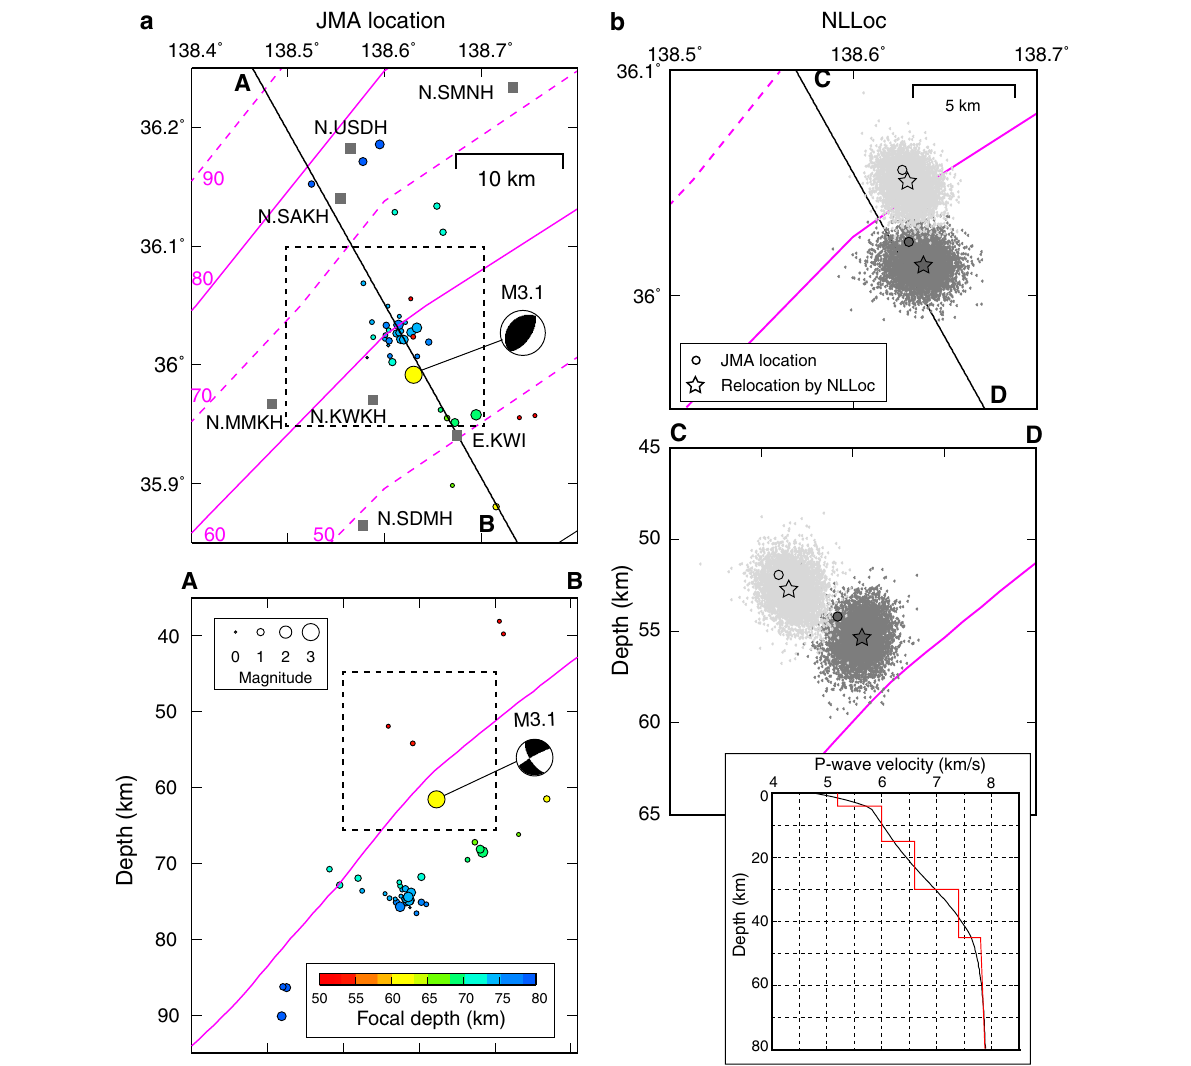
Fig. 3 a Map and cross-sectional views of the JMA locations of 42 earthquakes analyzed in this study. Colors and sizes of circles are proportional to the focal depth and magnitude, respectively. The focal mechanism of the M3.1 earthquake determined by the JMA is shown. Gray squares with names denote seismograph stations. The dashed rectangle outlines the area shown in b . b Density scatter plots (small dots) of two earthquakes at depths of 50–55 km. Circles and stars denote JMA hypocenters and hypocenters relocated by NLLoc (Lomax et al. 2000), respectively. In the inset, red and black lines denote the 1D P -wave velocity model used in NLLoc and the JMA2001 model (Ueno et al. 2001),